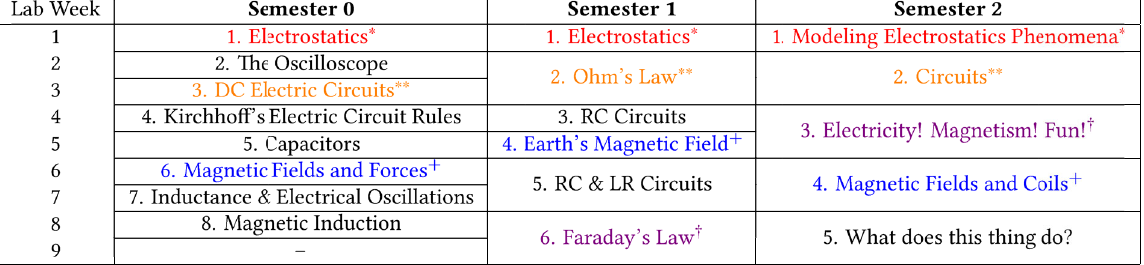
FIG. 3. Order of lab activities for semesters 0, 1, and 2. Titles reflect what was on the instructions provided to students. Symbols and colors indicate “ matched ” lab activities that use similar equipment and investigate similar physics